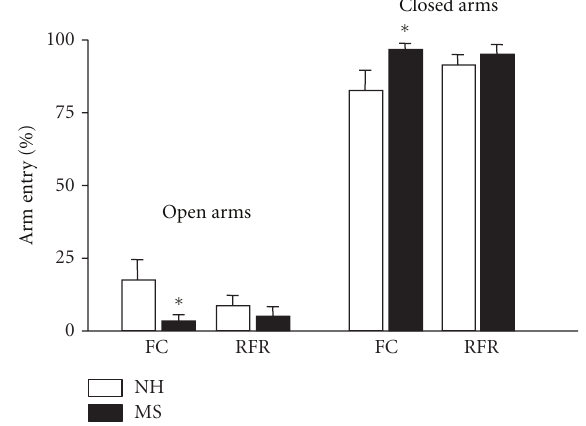
Figure 2: Percent arm entries during elevated plus maze test. The test was performed 2 days after the ambulatory test, at the end of the 14th refeeding session. ∗ P < 0.05 versus NH/FC, NH: nonhandled, MS: maternal separation, FC: free fed control, RFR: repeated fasting/refeeding. Data are presented as means ± S.E.